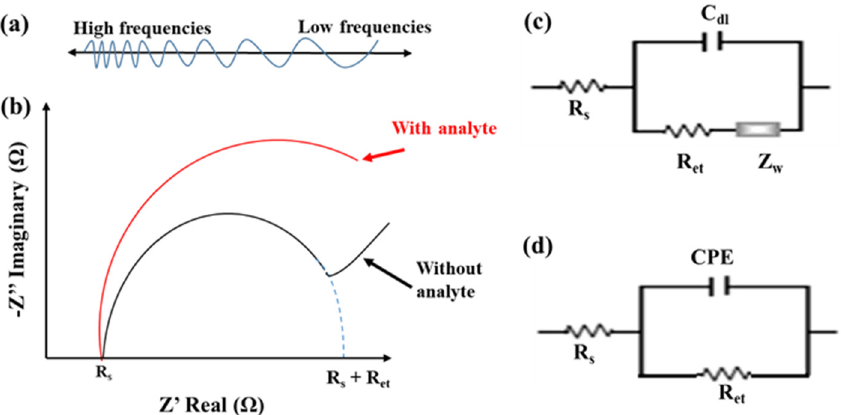
Figure 4. ( a ) The DC equilibrium potential superimposed with a frequency-varied AC voltage for EIS measurement. ( b ) Typical Nyquist plots measured by EIS with and without analyte immunoreaction. ( c ) The Randels equivalent circuit. ( d ) 1R//C equivalent circuit.